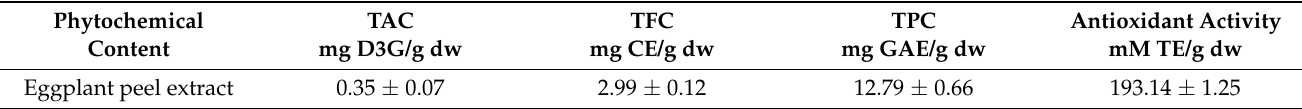
Table 1. The phytochemical content of the eggplant peel